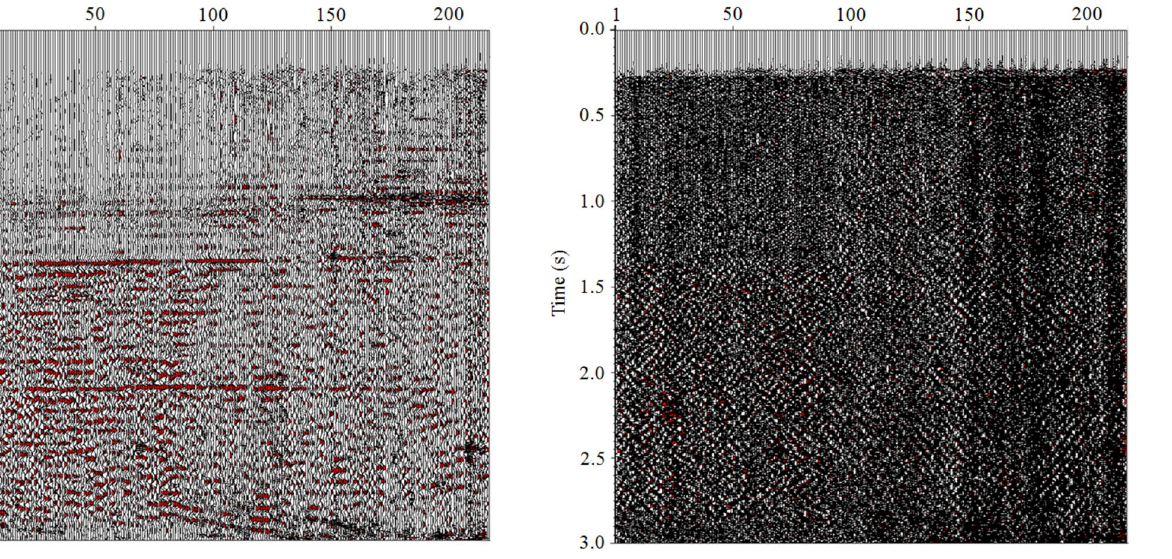
Fig. 18 Removed noises (the difference plot between Figs. 14, 15)